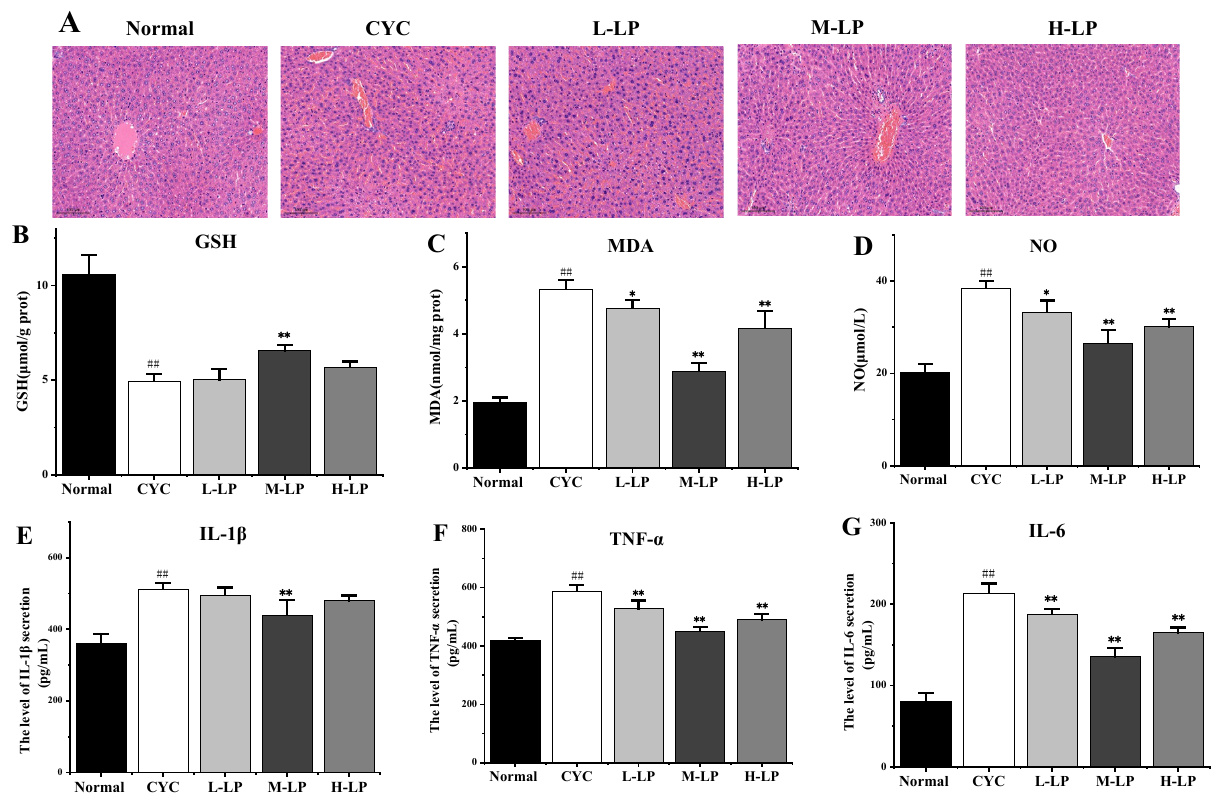
Figure 4. Effects of LP on CYC-induced liver injury in mice. ( A ) Effects of LP on morphology and structure of liver tissue in mice (20×). ( B – G ) Effects of LP on GSH ( B ), MDA ( C ), NO ( D ), IL- 1β ( E ), TNF- α ( F ), and IL-6 ( G ) in mouse liver tissues. Note: n = 3, ## p < 0.01 vs. Normal group, * p < 0.05, ** p < 0.01 vs. CYC group.